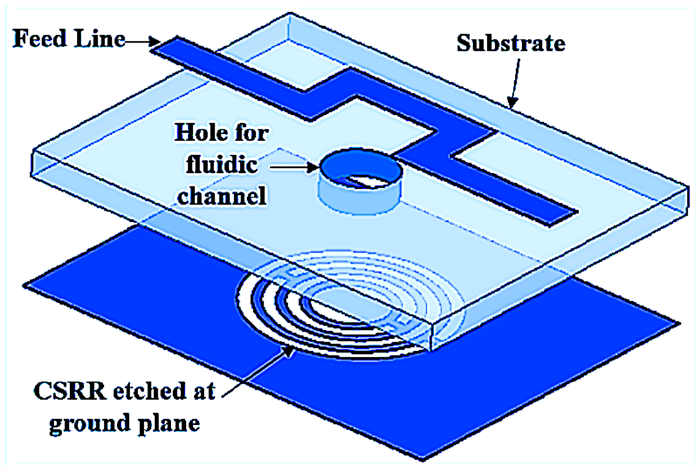
Figure 6. Perspective view of triple-rings CSRR sensor.